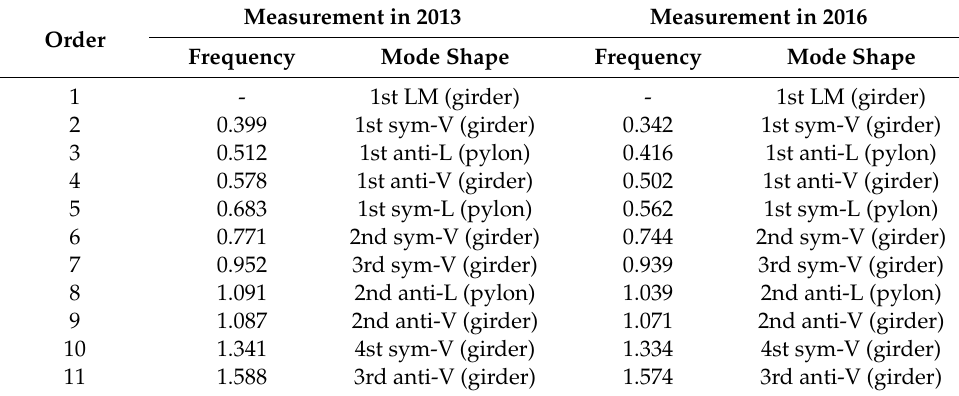
Table 2. Modal analysis results from the measurements in 2013 and 2016.